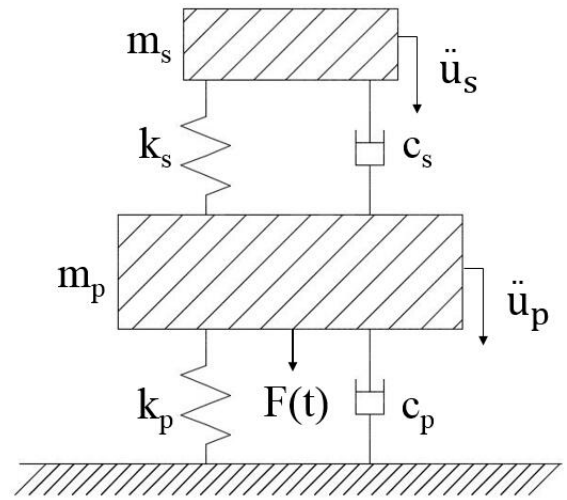
Figure 1. The dynamic system coupled with a tuned mass dampers (TMD) under an external excitation.